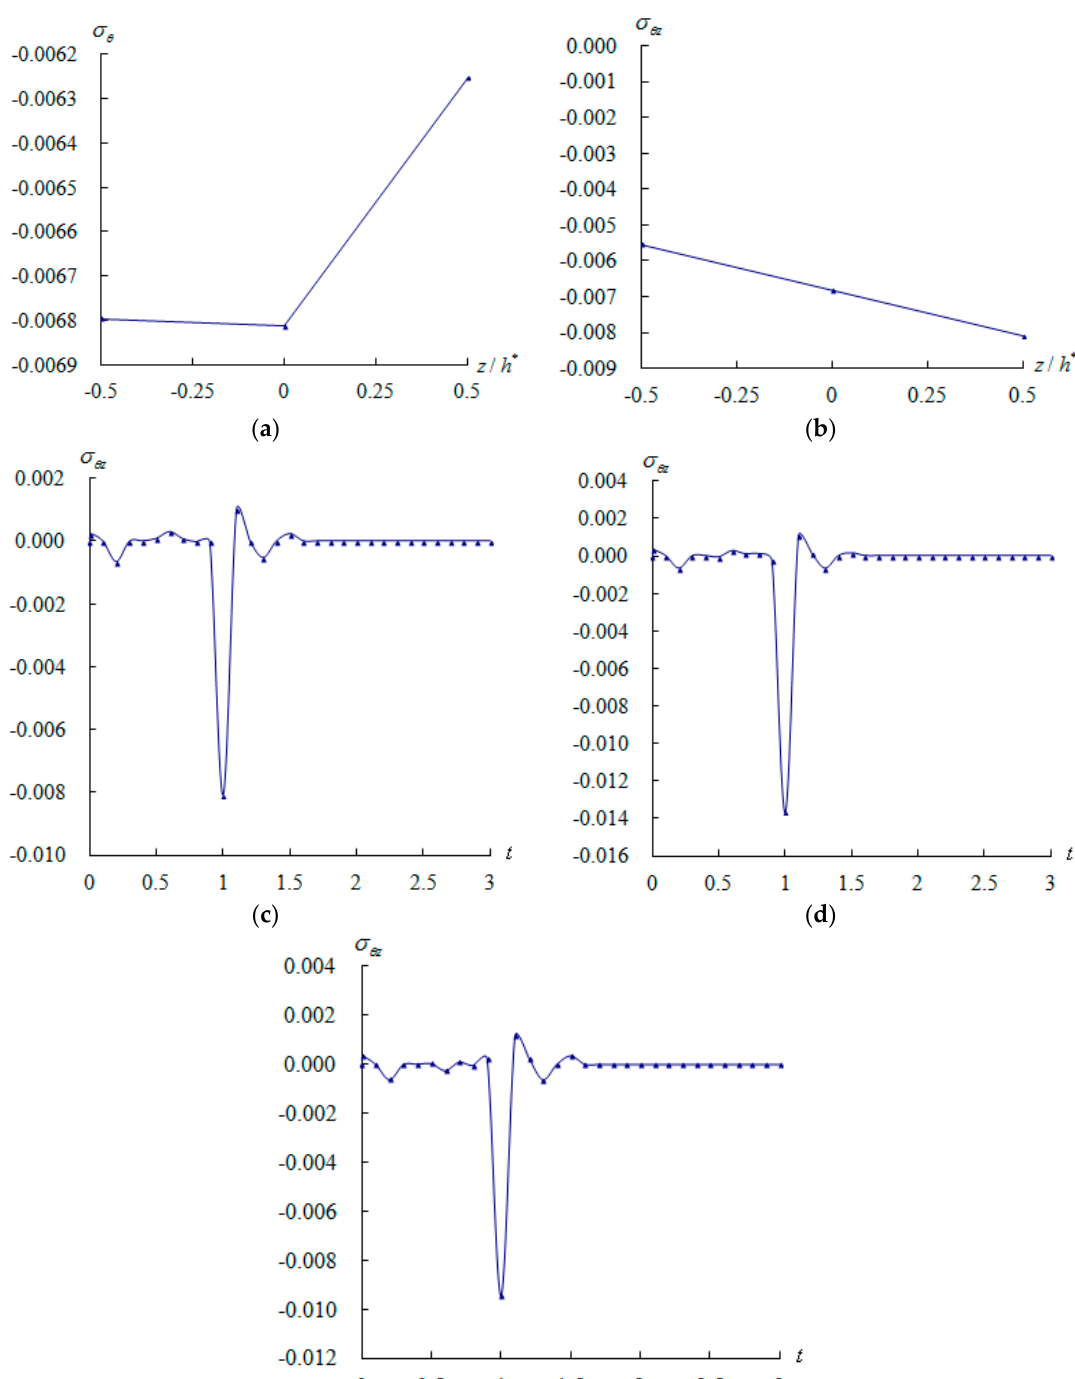
σ ∗ for M ∞ = 2 at (GP a ) versus Figure 5. Stresses versus z / h ∗ and t for M ∞ = 2, 4 and 10: ( a ) σ θ (GP a ) versus z / h